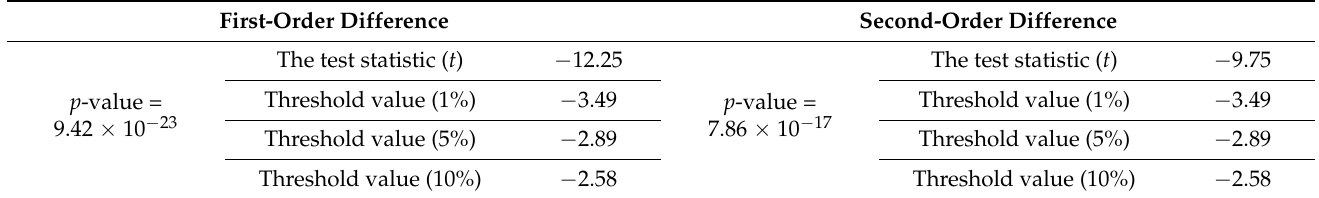
Table 2. Comparison of first-order differences versus second-order differential results